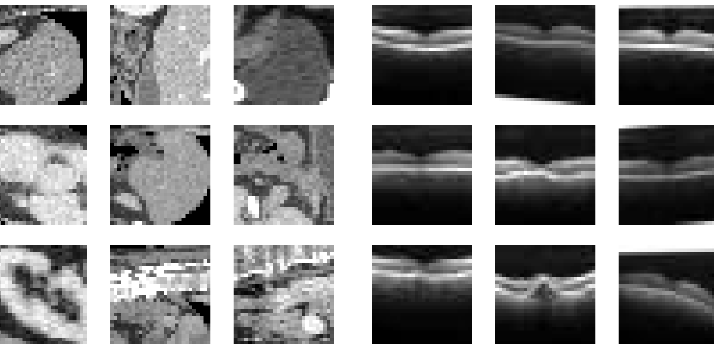
Figure 2. Some examples from MedMNIST2D OrganSMNIST ( left half ) and OCTMNIST ( right half